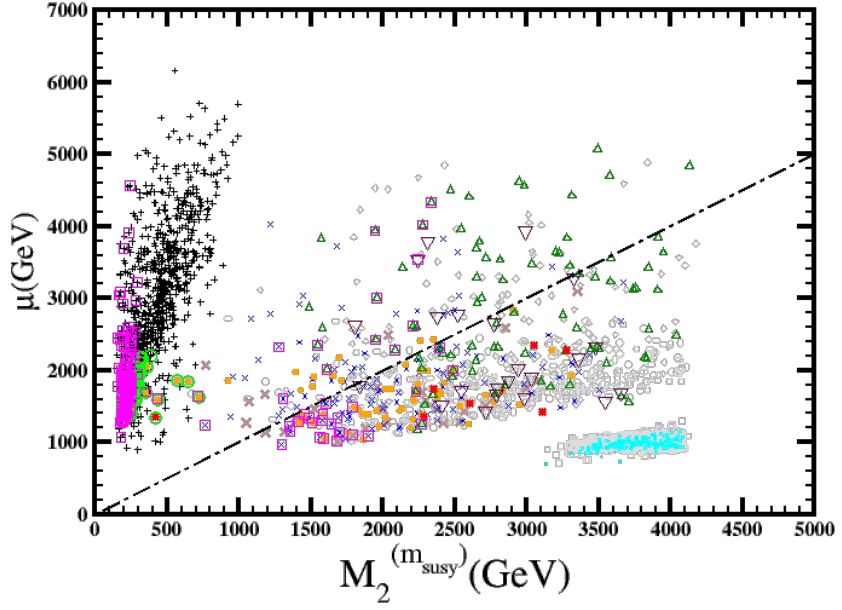
Figure 7 . Scatter plots in the (cid:22) (cid:0) M 2 plane. Only points analyzed with Smodels are shown with the same legends as in previous (cid:12)gures (the brown crosses corresponding to A/H resonances are thicker than in the previous plots). The gray symbols correspond to points not analyzed with Smodels, squares are for Higgsino DM, circles for A/H resonances and diamonds for stop coannihilations. The dot-dash line represents (cid:22) = M 2